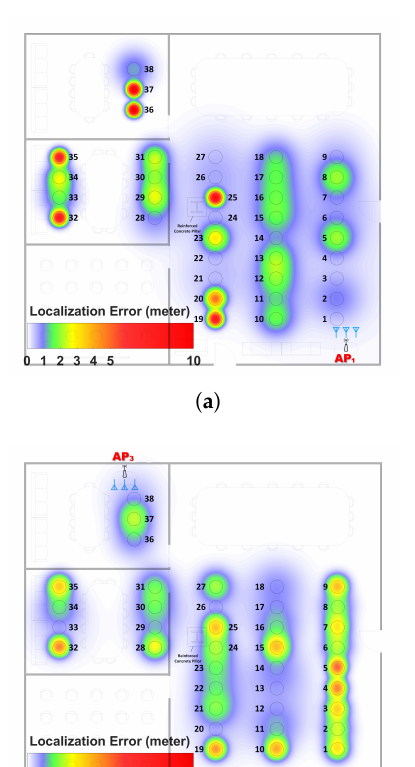
Figure 10. TP-based error map of three different APs. The red circles are BPs, the yellow circles are MA LP s and the green circles are HA LP s. The blue symbols show the orientation of the antenna array. ( a ) AP 1 has a rich LoS with most locations in the V-shaped sector of the antenna array; ( b ) AP 2 has a rich LoS with most locations out of the V-shaped sector; ( c ) AP 3 has an NLoS scenario.